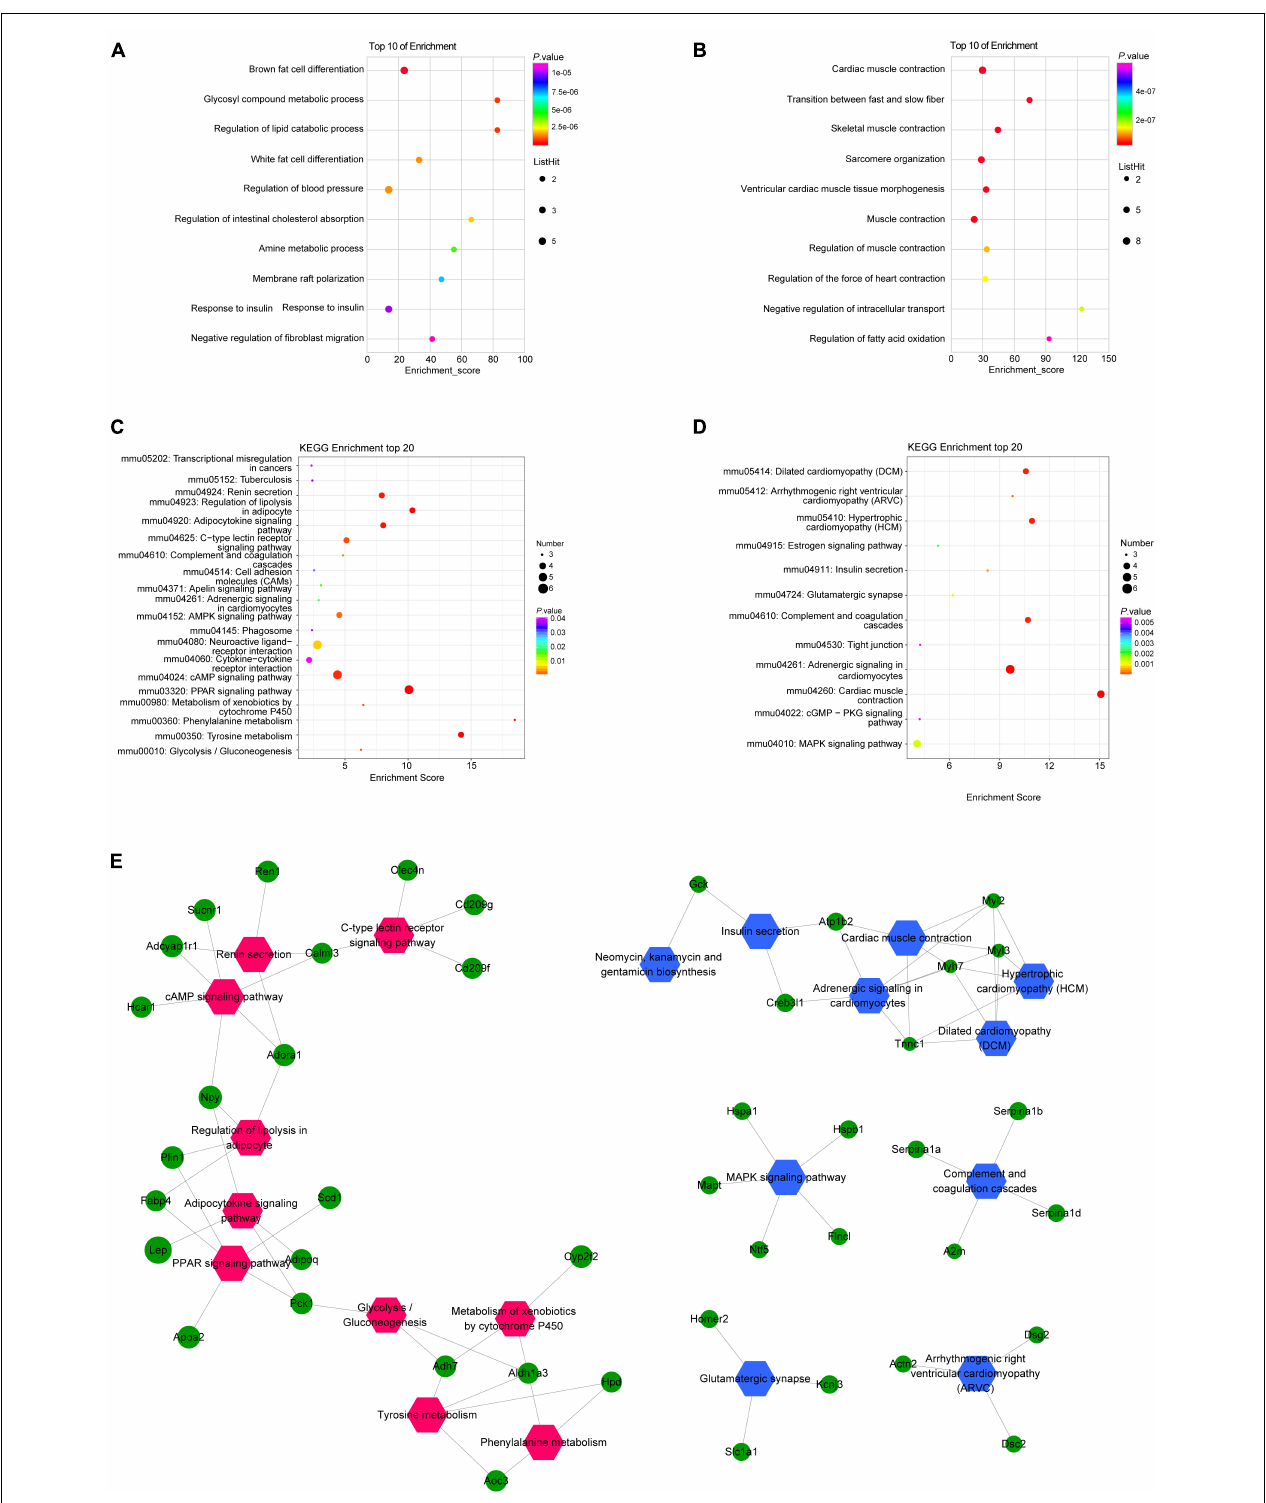
FIGURE 4 | Gene Ontology (GO) and Kyoto Encyclopedia of Genes and Genomes (KEGG) pathway analyses of mRNAs in OVX. GO annotations of up (A) and down (B) regulated mRNAs with top 10 enrichment scores of biological processes. KEGG pathway enrichment analysis of up (C) and down (D) regulated mRNAs with top 20 enrichment scores. Interaction and overlapping of associated molecules among significant pathways (E) . Hexagons represent the most significantly enriched pathways; ellipses indicate mRNAs that act as the link hinge between the pathways.